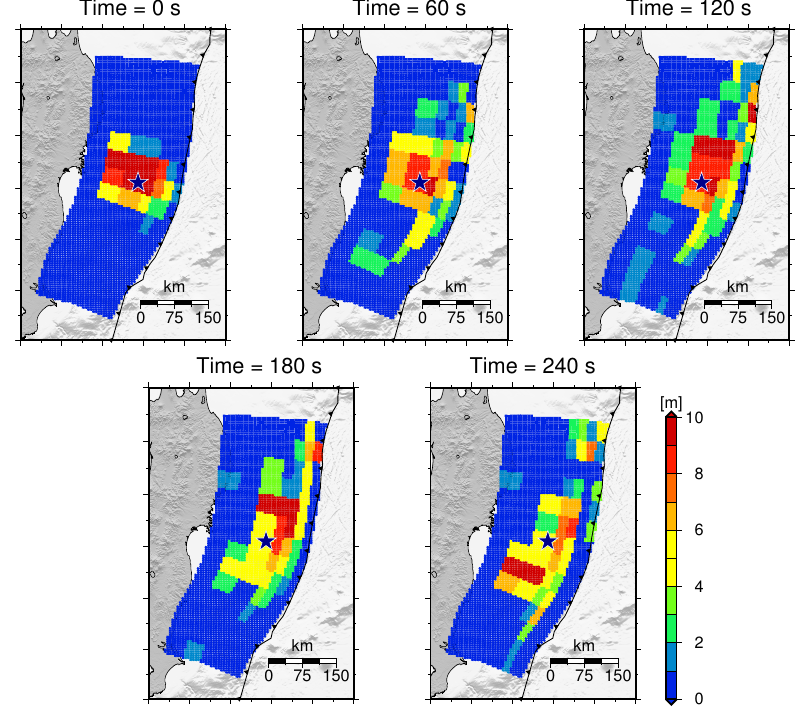
Figure 2. Spatio-temporal slip distribution of the earthquake source proposed by the Cabinet Office of Japan [9]. The blue star indicates the epicentre